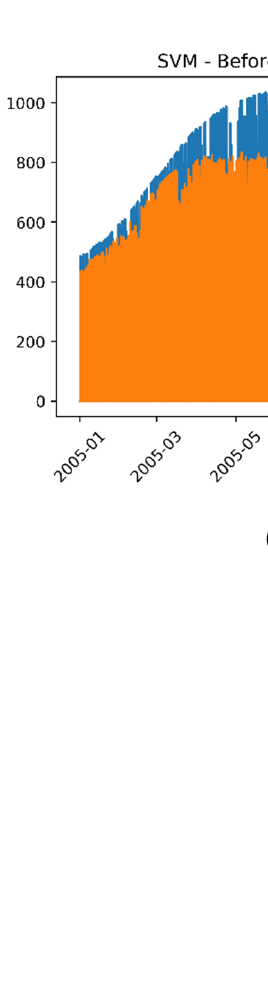
Figure 9. Comparison of ( a ) FBP and ( b ) SVM of seasonal adaptation versions.